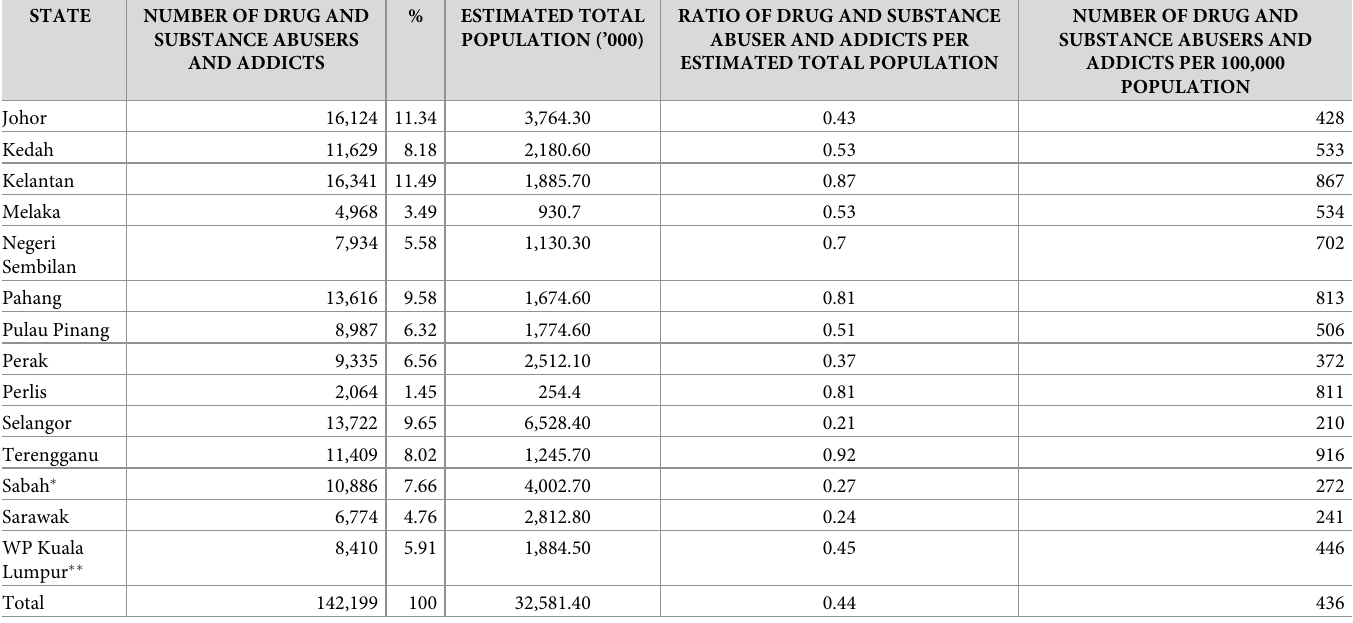
Table 1. Number of drug and substance abusers and addicts according to state in Malaysia and estimated total population in 2019. STATE NUMBER OF DRUG AND SUBSTANCE ABUSERS AND